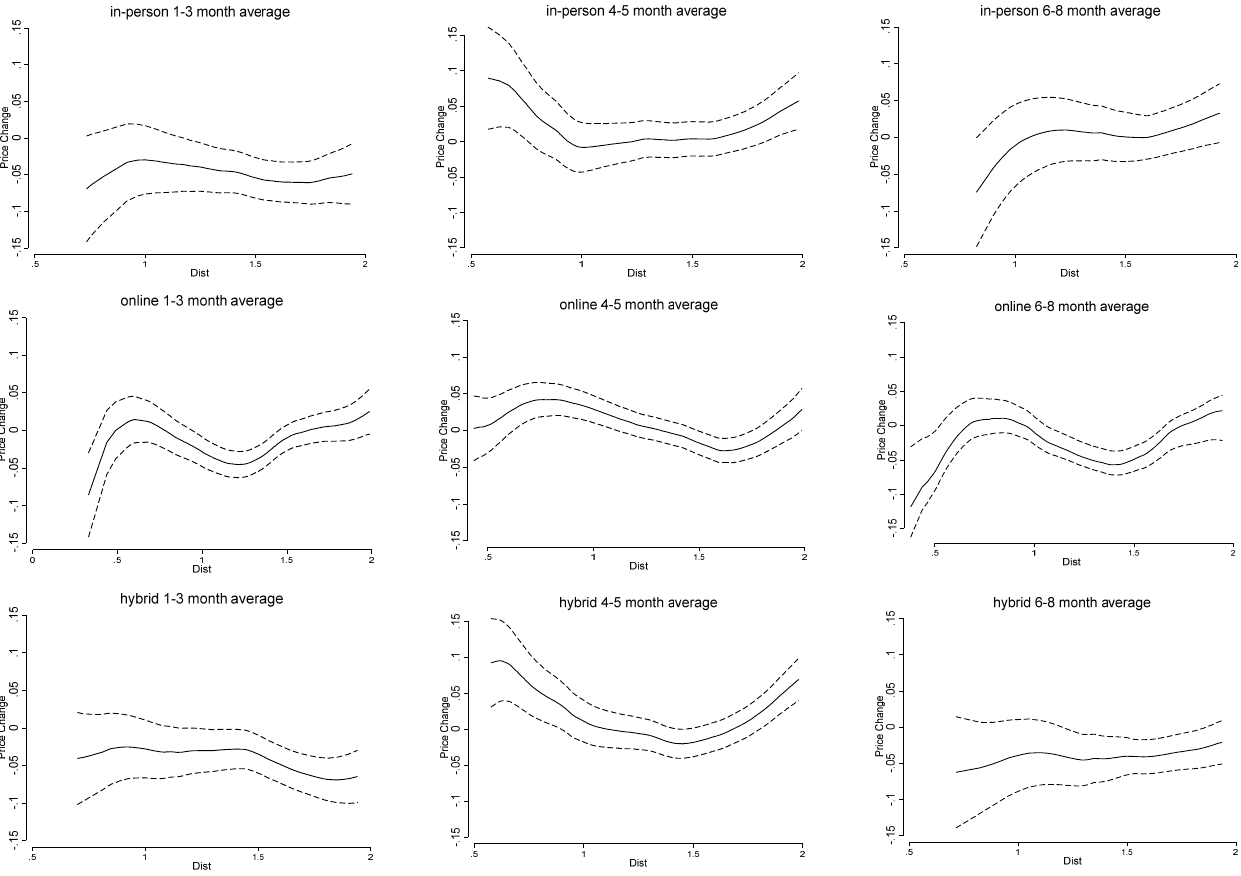
Figure 4. The effect of proximity to universities on house prices following the outbreak of COVID − 19, by teaching modes. Note: these figures show the estimates with respect to distance averaged over respective months after the COVID outbreak. The horizontal axis provides distance to the university in miles. The vertical axis denotes the effect on neighboring house prices. The 90% confidence bonds are also provided.